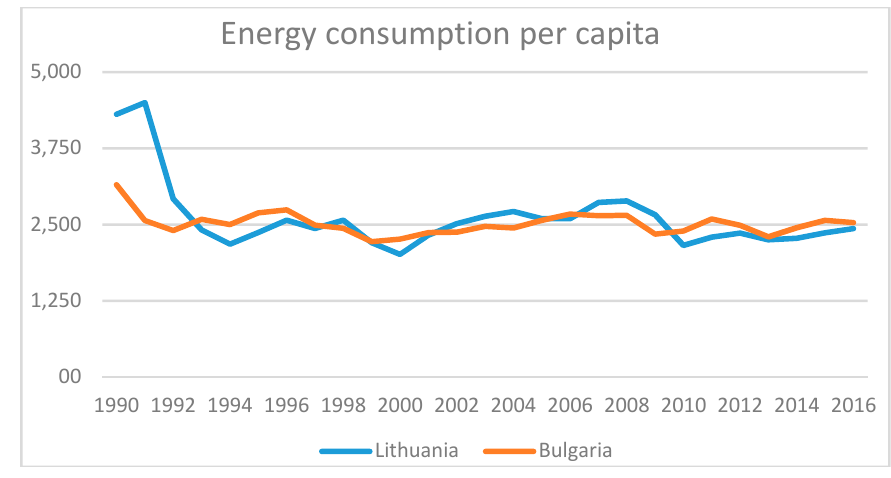
Figure 13. Energy consumption per capita dynamics in Lithuania and Bulgaria, kgoe/cap. Source: [39,40].